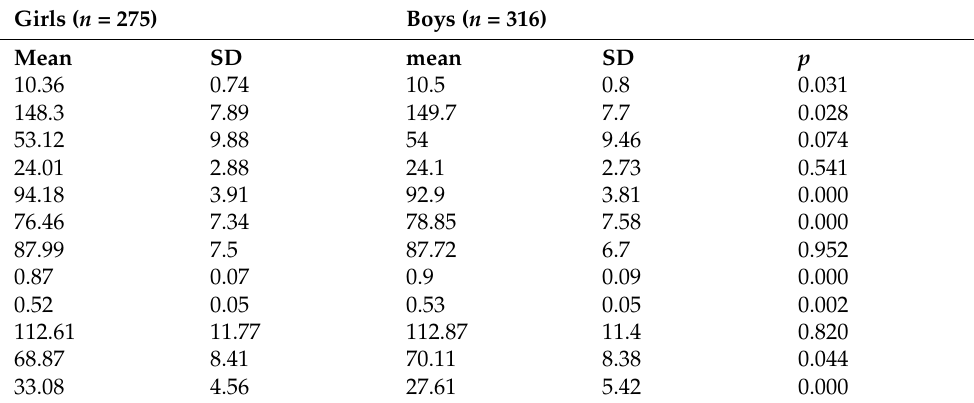
Table 1. Results of anthropometry, blood pressure, and fat tissue content in the study population. Girls ( n = 275) Boys ( n = 316) Mean